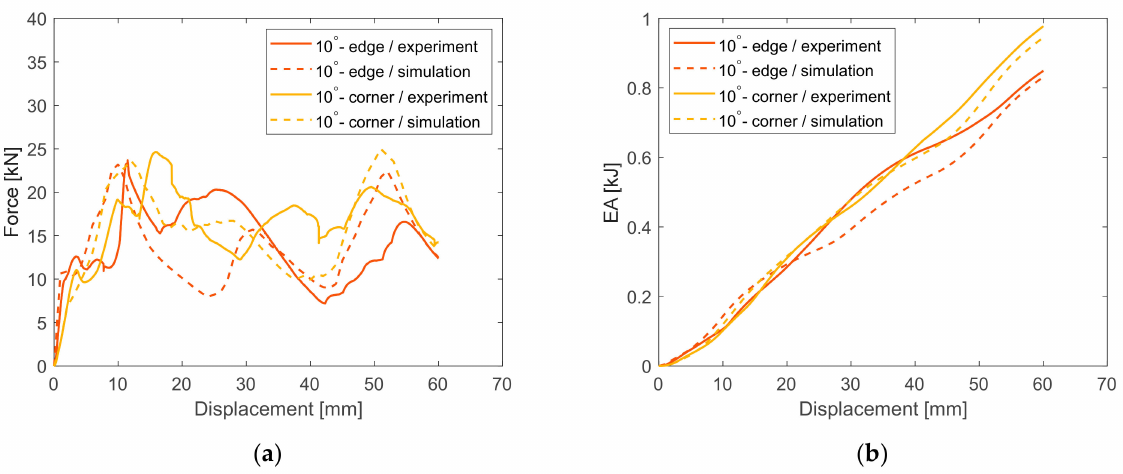
Figure 7. Experimental and numerical results of 10 ◦ crushing angle for cornered and edged oblique impact. ( a ) force-displacement curve; ( b ) EA-displacement